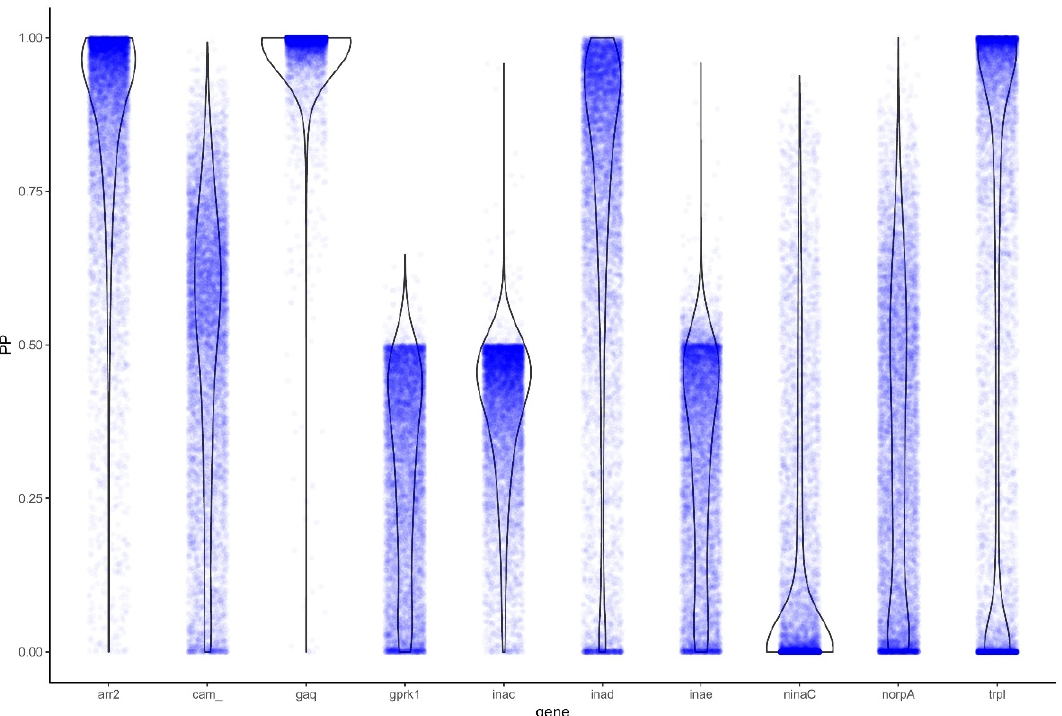
Figure 3. Distributions of the posterior probability (PP) of positive selection across phototransduction genes. Violin plots represent estimated kernel density MCMC posterior probability of positive selection (blue dots).